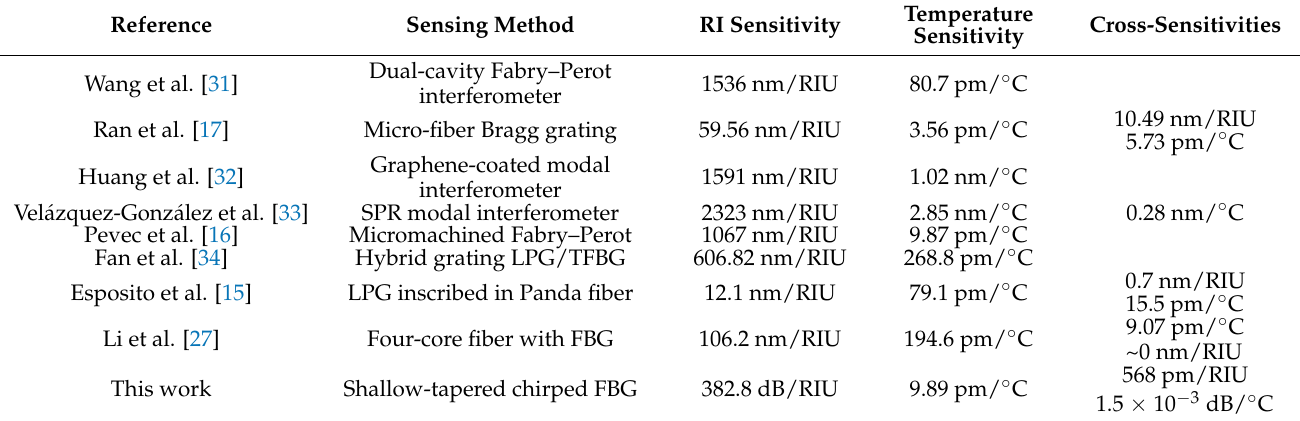
Table 2. Comparison of the main methods for dual RI/temperature fiber optic sensing, outlining the main performance